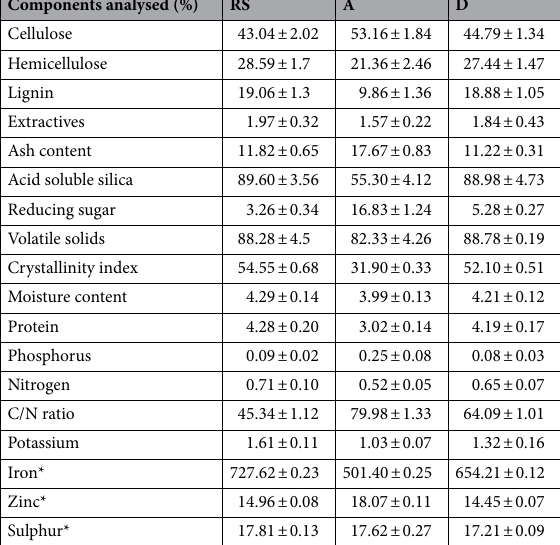
Table 1. Compositional analysis results of native (RS), PWW pretreated (A) and distilled water pretreated (D) rice straw with standard deviation. *μg/g Dry weight .